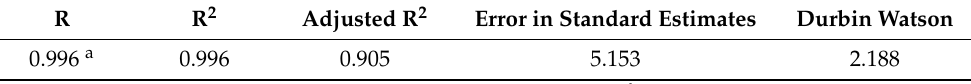
Table A3. Model summary b .